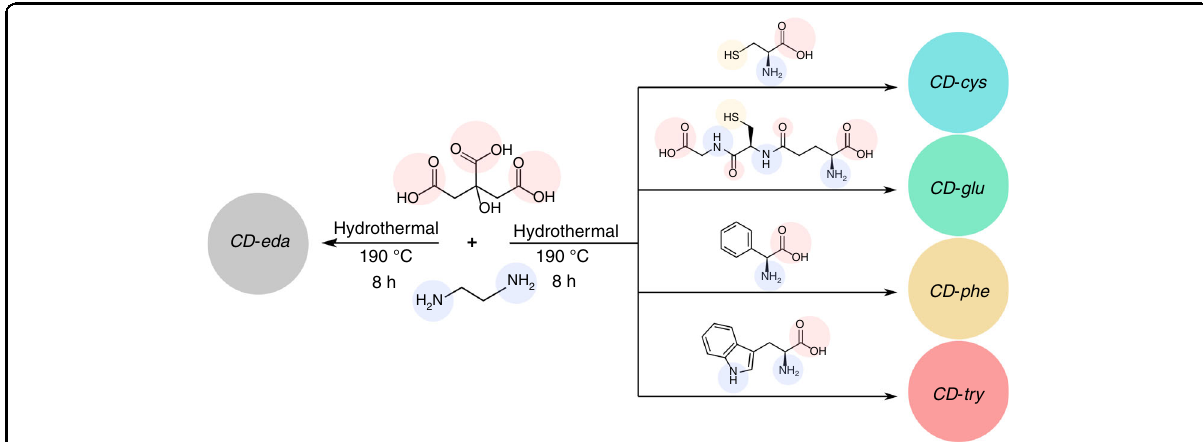
Fig. 1 Syntheses of achiral CDs ( CD-eda ) and chiral CD samples ( CD-cys , CD-glu , CD-phe , and CD-try ). Common precursors citric acid and ethylenediamine were combined with a set of different chiral precursors, L -cysteine, L -glutathione, L -phenylglycine, and L -tryptophan. Chemical functional groups present in the precursor molecules, namely, carboxylic, amino, and thiol groups, are highlighted by blue, red, and yellow semitransparent circles,